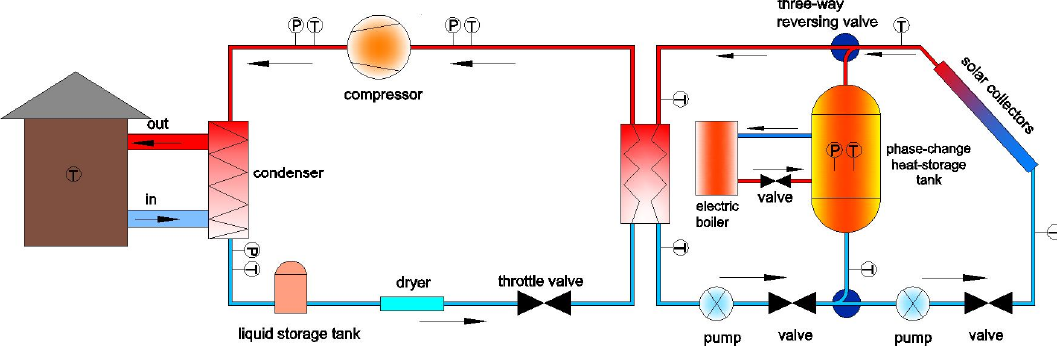
Figure 1. Schematic diagram of phase-change energy-storage coupled solar heat pump system. P—(Pressure Sensor), T—(Temperature Sensor).